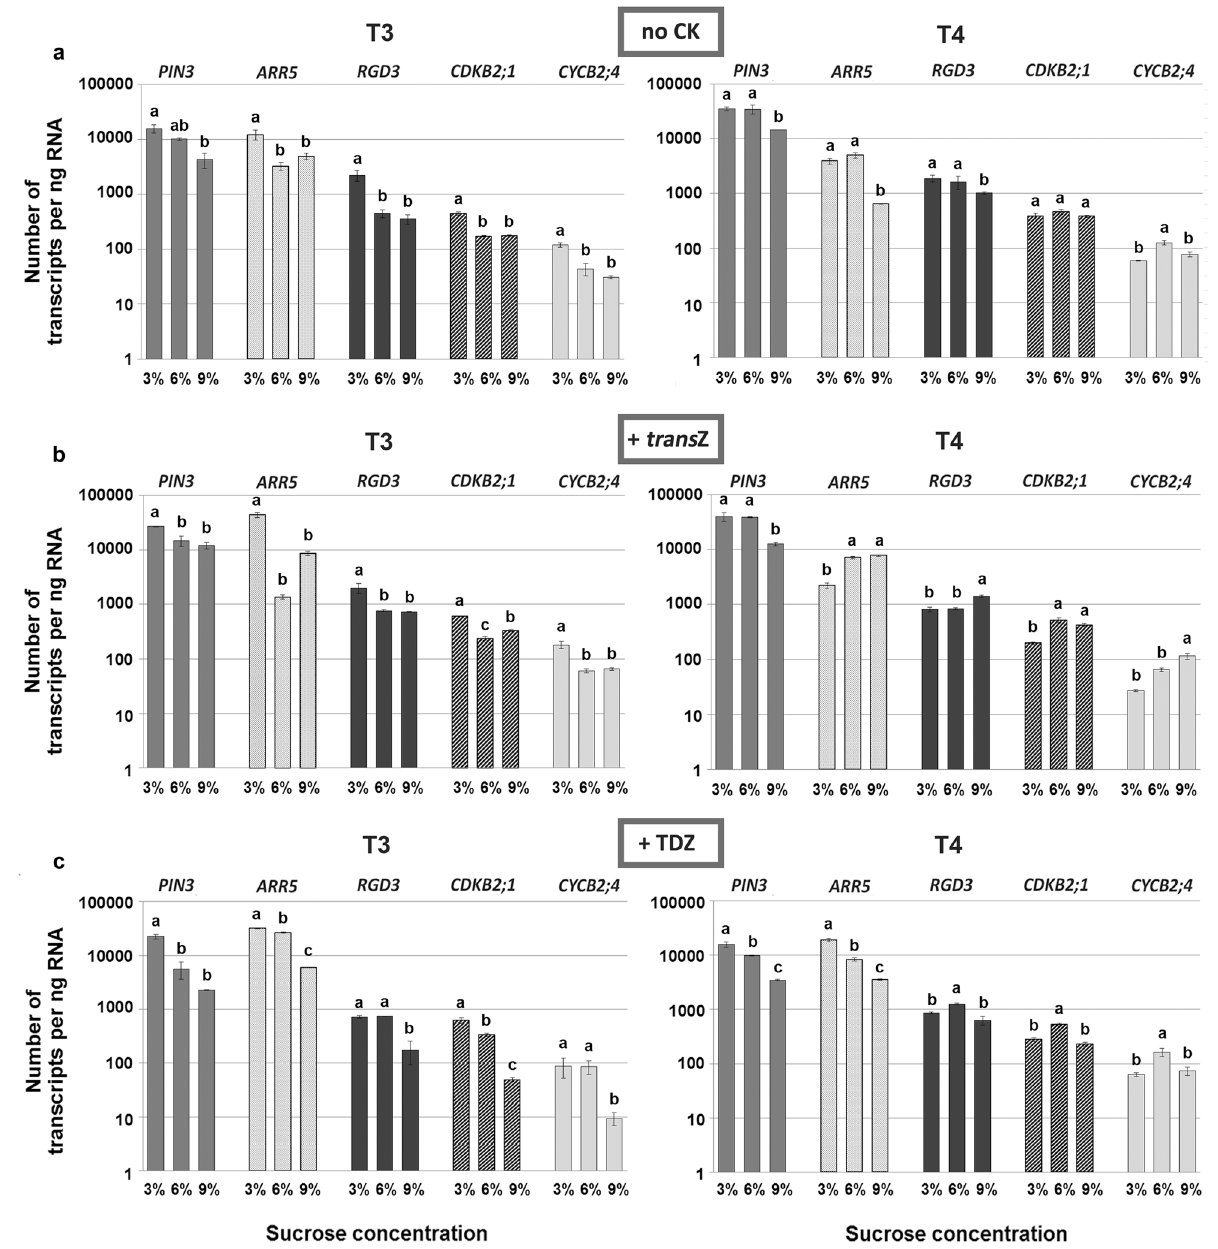
Figure 5. Absolute expression profiles of PIN3 , ARR5 , RGD3 , CDKB2;1 and CYCB2;4 genes in later developmental stages (T3 and T4) during kohlrabi (cv. Vienna Purple) growth and de novo shoot organogenesis on media containing 3/6/9% sucrose without cytokinins ( a ), with 2 mg L −1 trans Z ( b ) or with 2 mg L −1 TDZ ( c ). Data are shown as the mean ± SE (n = 3 independent biological replicates). Means marked with the same letter for each distinct gene were not significantly different according to the LSD post-hoc test, P ≤ 0.05. trans Z: trans - zeatin; TDZ: